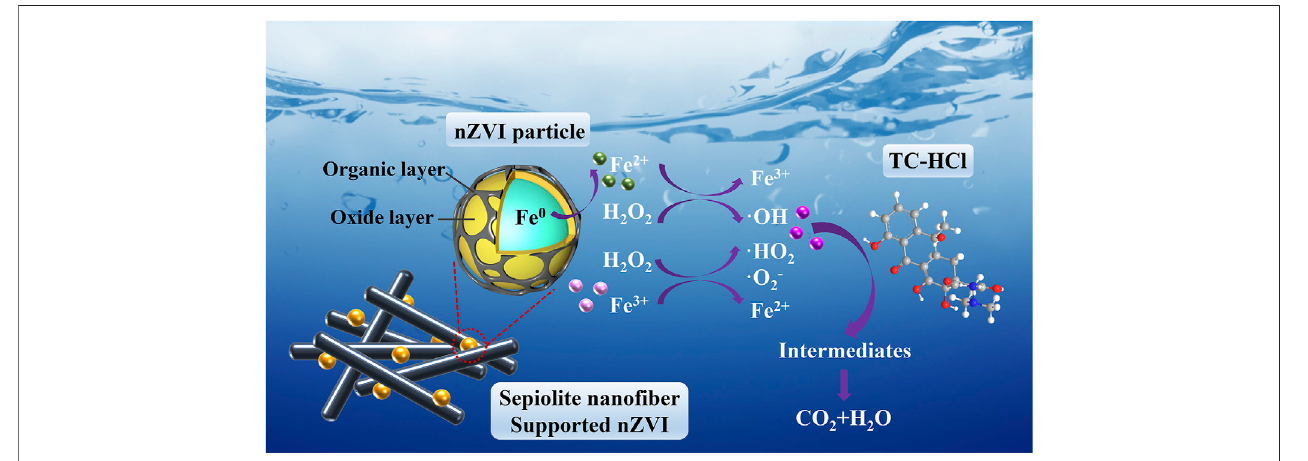
FIGURE 11 | Removal mechanism for TC-HCl on nZVI/SEP composite in Fenton-like